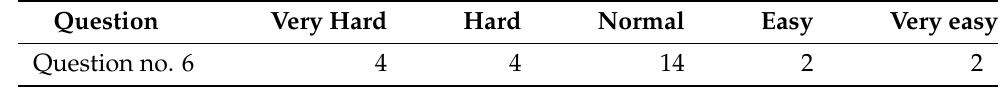
Table 10. Perception of mathematics before the course.